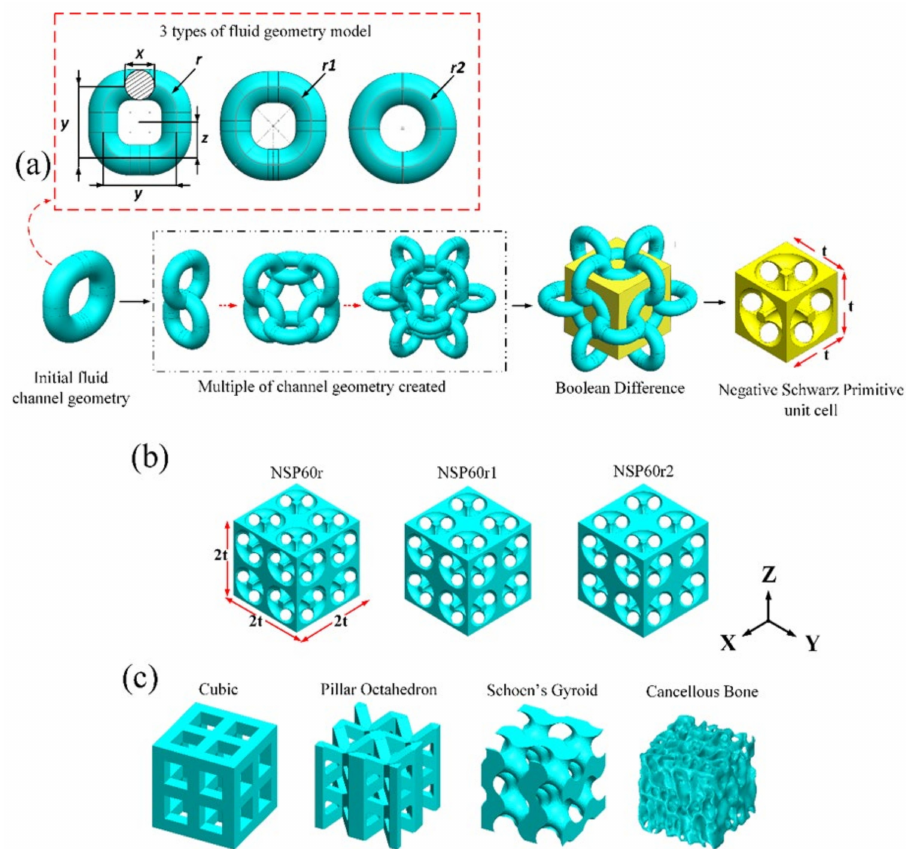
Figure 1. Schematic illustration of the scaffold design stage: ( a ) process schematic diagram showing the principles of scaffold design based on the concept of meandering pore channels; ( b ) NSP scaffolds with 60% porosity and different tortuosities can be controlled by adjusting the fluid pore size and radius of curvature; ( c ) cubic, PO, SG and natural cancellous bone models with 60%